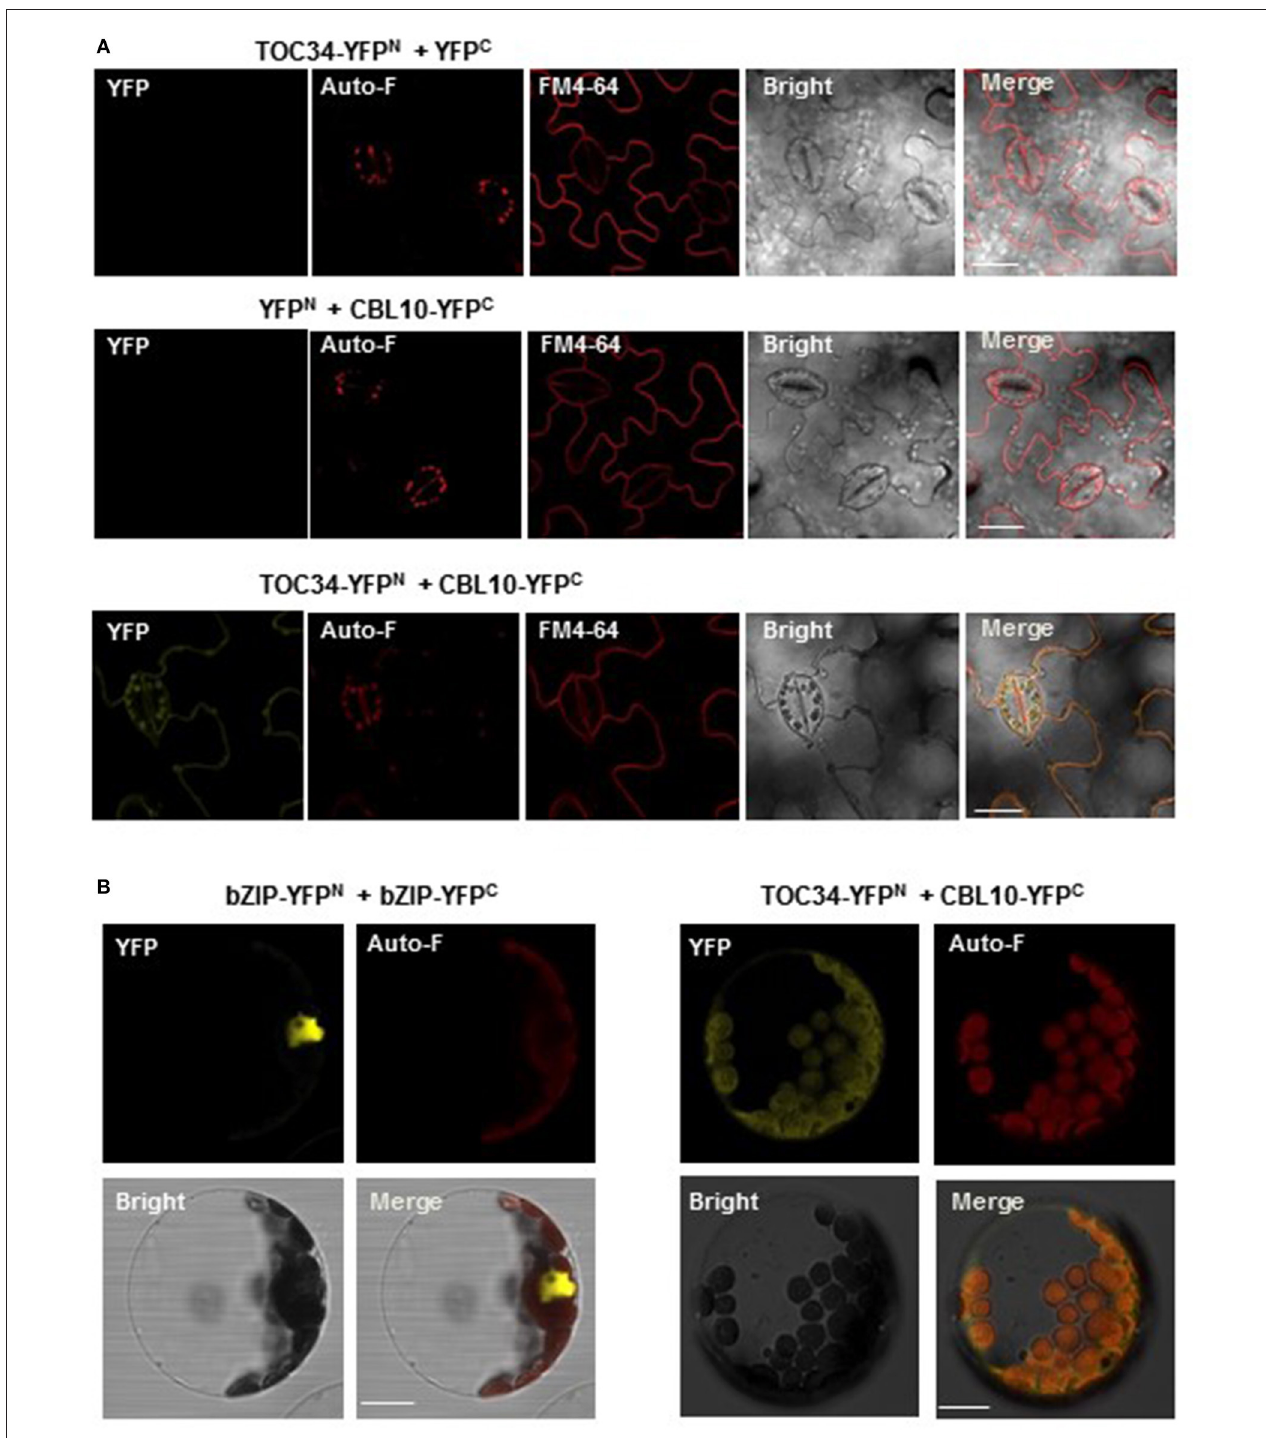
FIGURE 5 | In vivo interaction between CBL10 and TOC34. (A) Bimolecular fluorescence complementation (BiFC) analysis in tobacco ( Nicotiana benthamiana ) leaf epidermal cells infiltrated with Agrobacterium carrying indicated plasmid sets; TOC34-YFP N + YFP C (top row), YFP N + CBL10-YFP C (middle row), and TOC34-YFP N + CBL10-YFP C (bottom row). YFP, Auto-F, FM4-64, Bright, and Merge indicate YFP fluorescence signal, auto-fluorescence signal, N-(3-triethylammoniumpropyl)-4-(p-diethylaminophenyl-hexatrienyl) pyridinium dibromide (as a membrane marker) staining signal, bright field image, and merged image, respectively. Scale bars, 40 µ m. (B) BiFC analysis in Arabidopsis protoplasts expressing bZIP-YFP N and bZIP-YFP C (left two columns) or TOC34-YFP N and CBL10-YFP C (right two columns). Scale bars, 20 µ m.